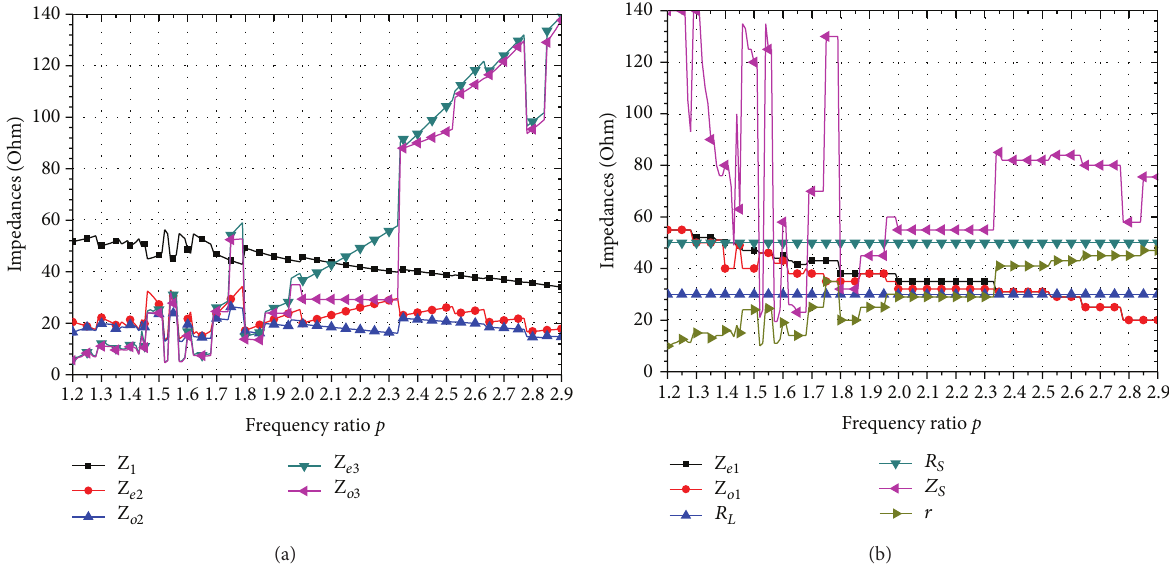
Figure 4: Typical design parameters of the proposed dual-band power divider with 𝑅 𝑆 = 50Ω , 𝑅 𝐿 = 30 Ω . (a) Values of 5 variables: 𝑍 1 , 𝑍 𝑒2 , , 𝑍 𝑍 𝑍 𝑜2 𝑒3 , and 𝑜3 . (b) Values of 6 free variables: